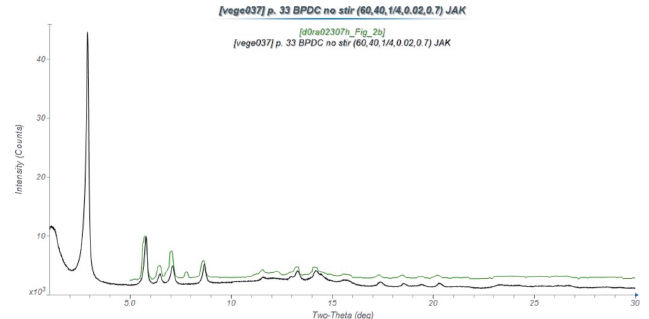
Figure 1 Comparison of the powder pattern of the Co 2 BPDC(OH) 2 of this study (black) to that reported by Ipadeola & Ozoemena (2020; green). The literature pattern (measured using Cu K (cid:3) radiation) was digitized using UN-SCAN-IT (Silk Scientific, 2013), and converted to Mo K (cid:3) using JADE Pro (MDI, 2021). Image generated using JADE Pro (MDI, 2021).